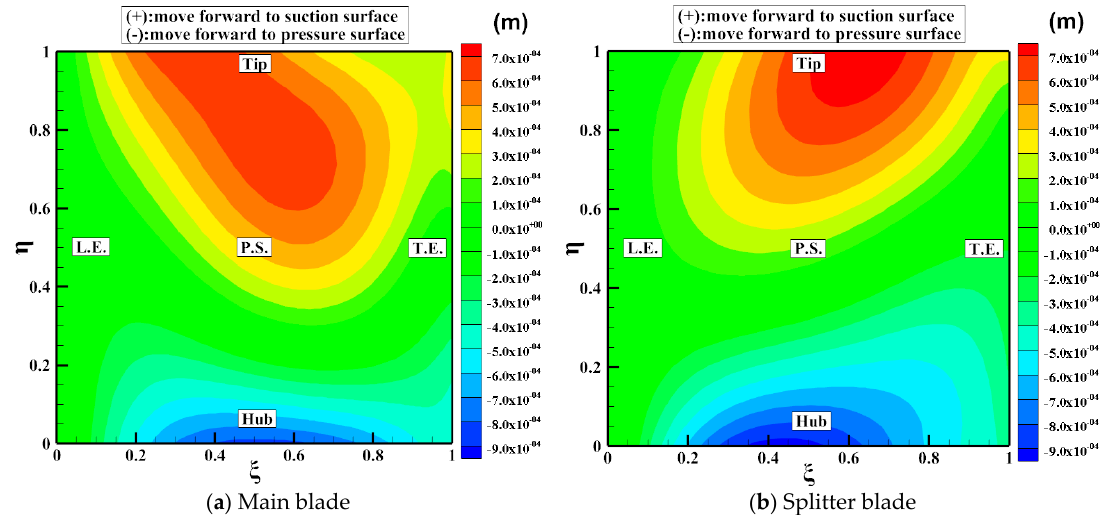
Figure 10. Comparison of Bezier surface deformation contour before and after optimisation.